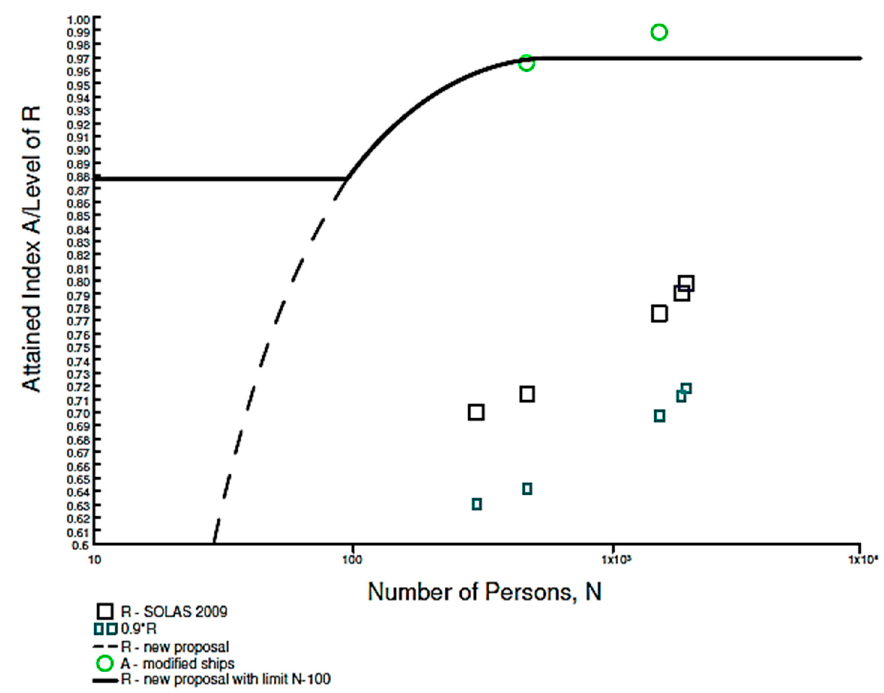
Figure 4. EMSA II research outcome on RoPax level of R index.